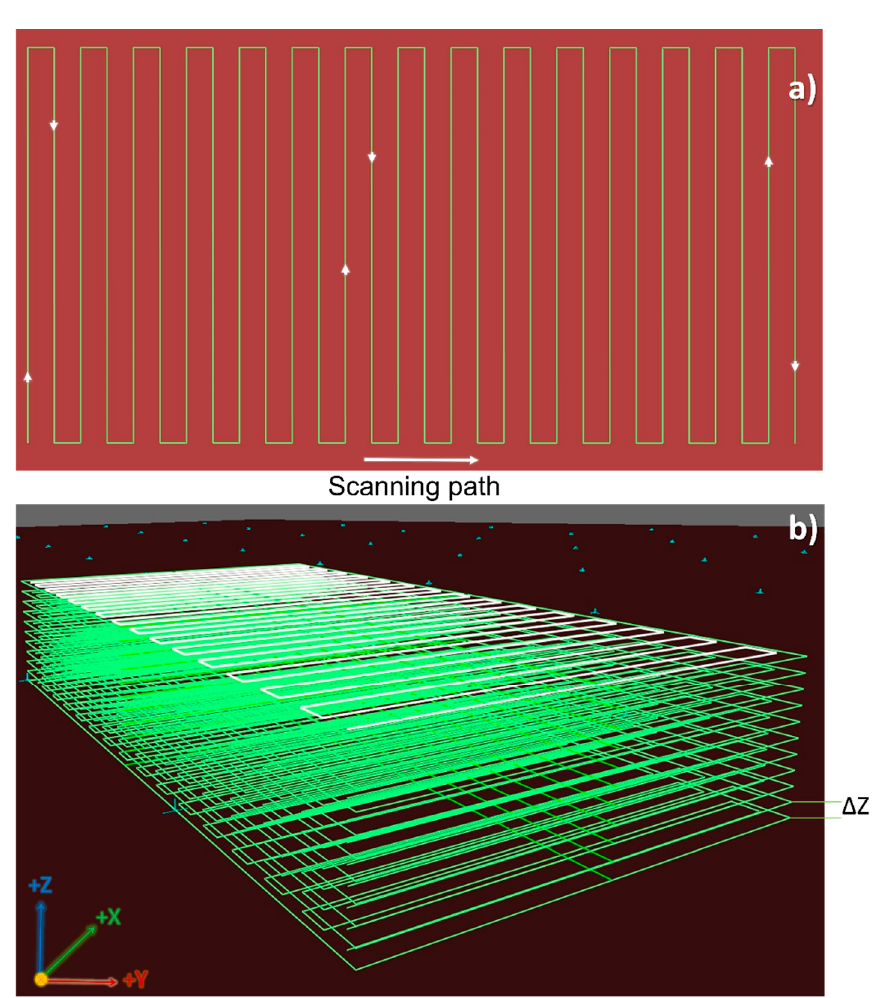
Figure 2. Laser beam path trajectory in form of a meander ( a ), Superposed meanders with offset between meander planes Δ Z ( b ).